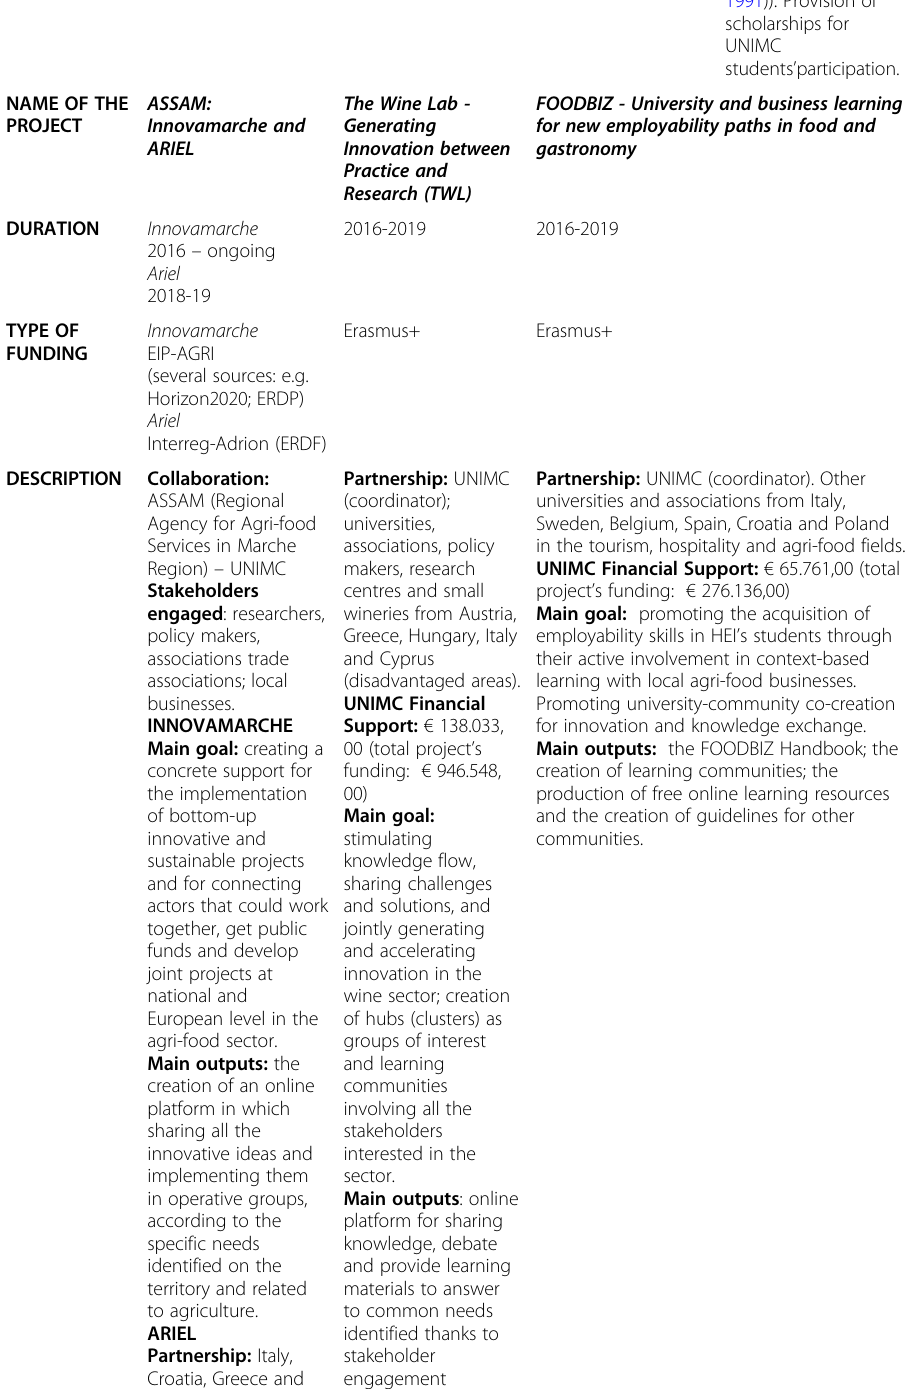
Table 2 Overview about the projects representing UNIMC ’ s civic engagement (own elaboration)